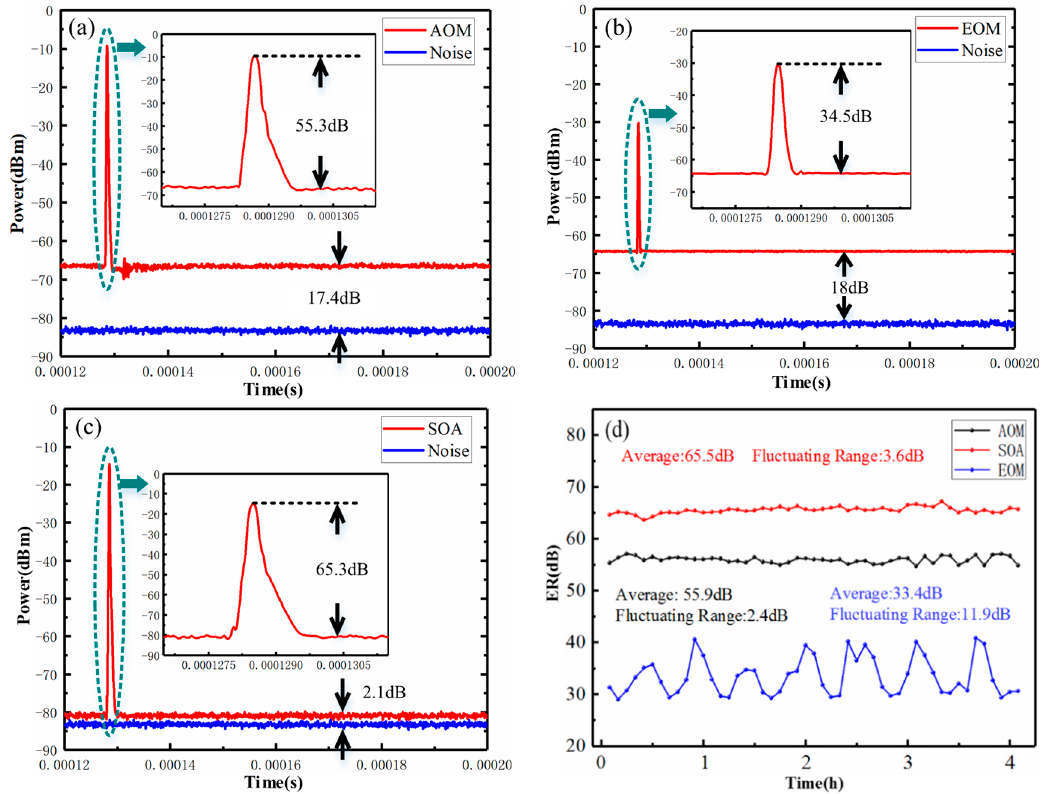
Figure 2. ER measurement results of ( a ) acousto-optic modulator (AOM), ( b ) electro-optic modulator (EOM), and ( c ) semiconductor optical amplifier (SOA). ( d ) ER stability evaluation results of AOM, SOA, and EOM.